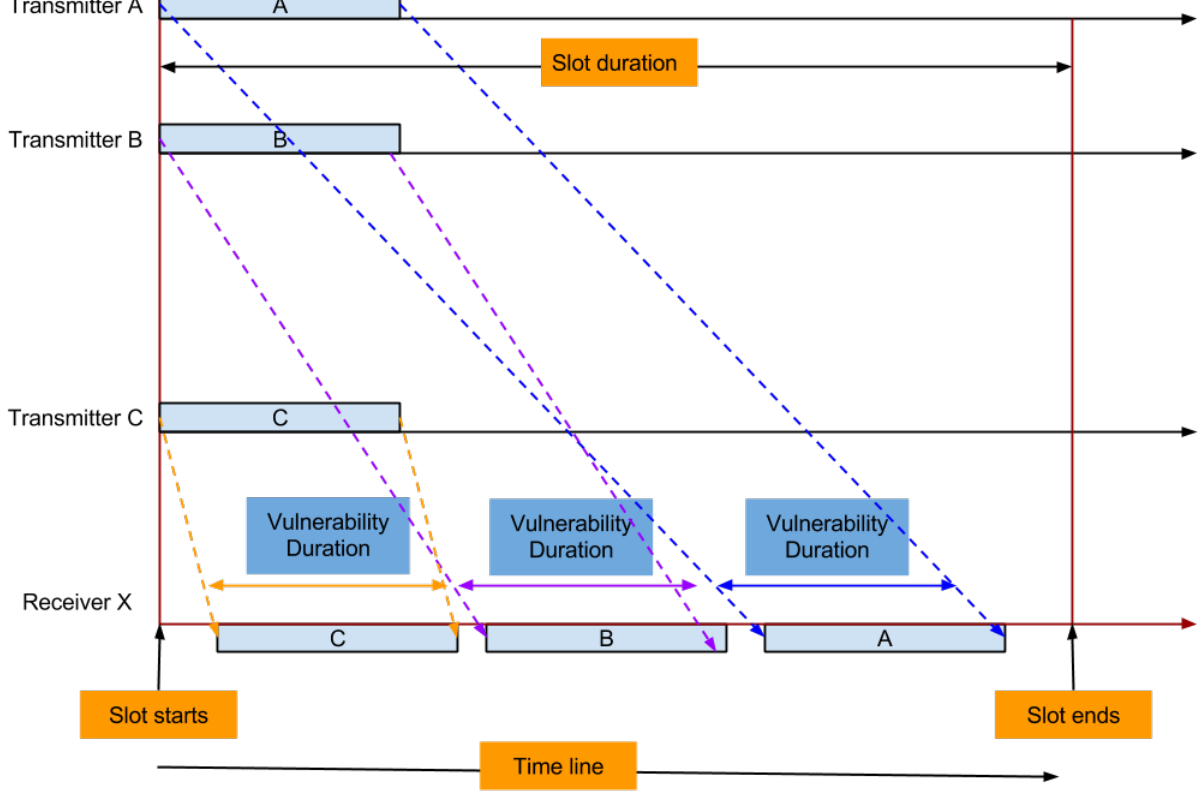
Figure 4. Successful reception and vulnerability duration of a